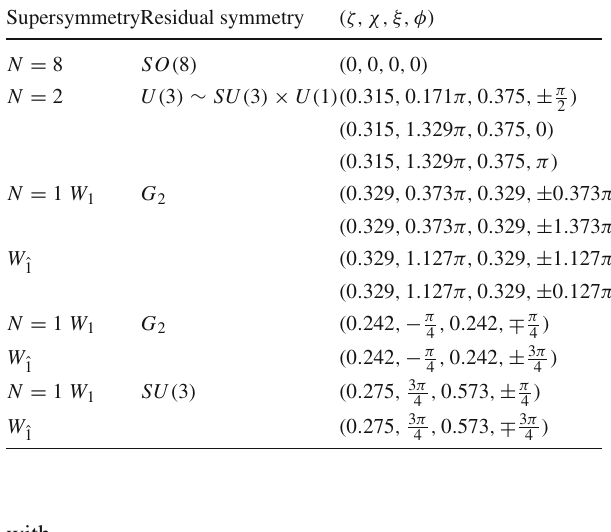
Table 1 Supersymmetic AdS 4 vacua of SO ( 8 ) gauged supergravity with ω = π . The first three critical points have ω = 0 counterparts 8 whilethelasttwoaregenuinecriticalpointsofthedyonic SO ( 8 ) gauged supergravity without the ω = 0 analogues. For N = 1 critical points, we also note which superpotential among W 1 and W ˆ the unbroken